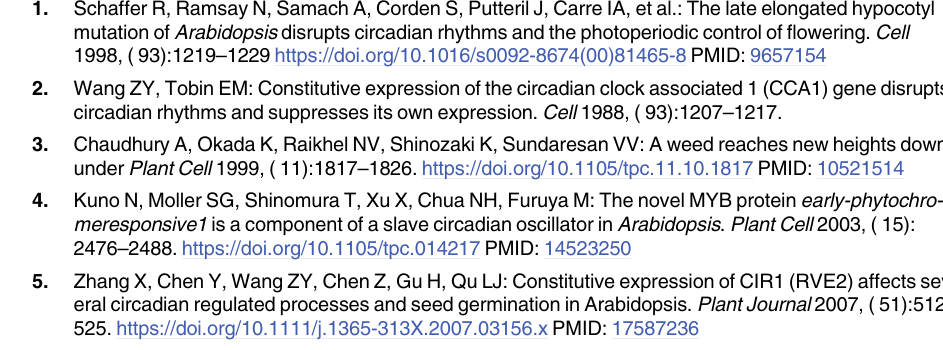
S4 Table. Comparison of average chlorophyll content (mgg-1) in T2 transgenic progeny plants at different time points; 6:00AM, 12:00 Noon, 6:00 PM and 9:00 AM the